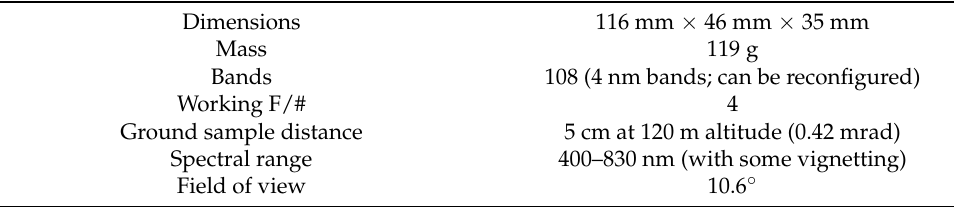
Table 2. OpenHSI